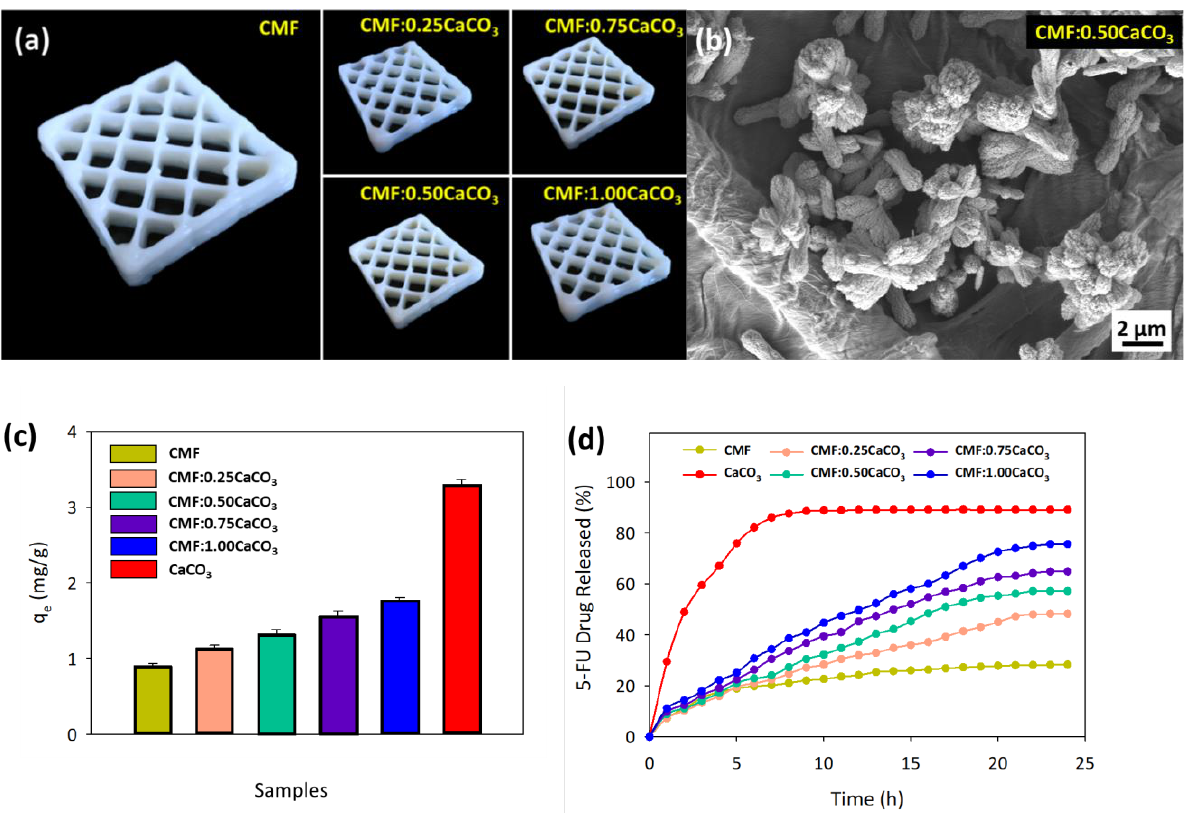
Figure 7. ( a ) Printed CMF/CaCO 3 scaffold, ( b ) morphological view of CMF/0.50CaCO 3 , ( c ) adsorption capacity of CMF/CaCO 3 composite, and ( d ) 5-fluorouracil drug release profile. The data are presented as mean ± standard deviation (n = 3).